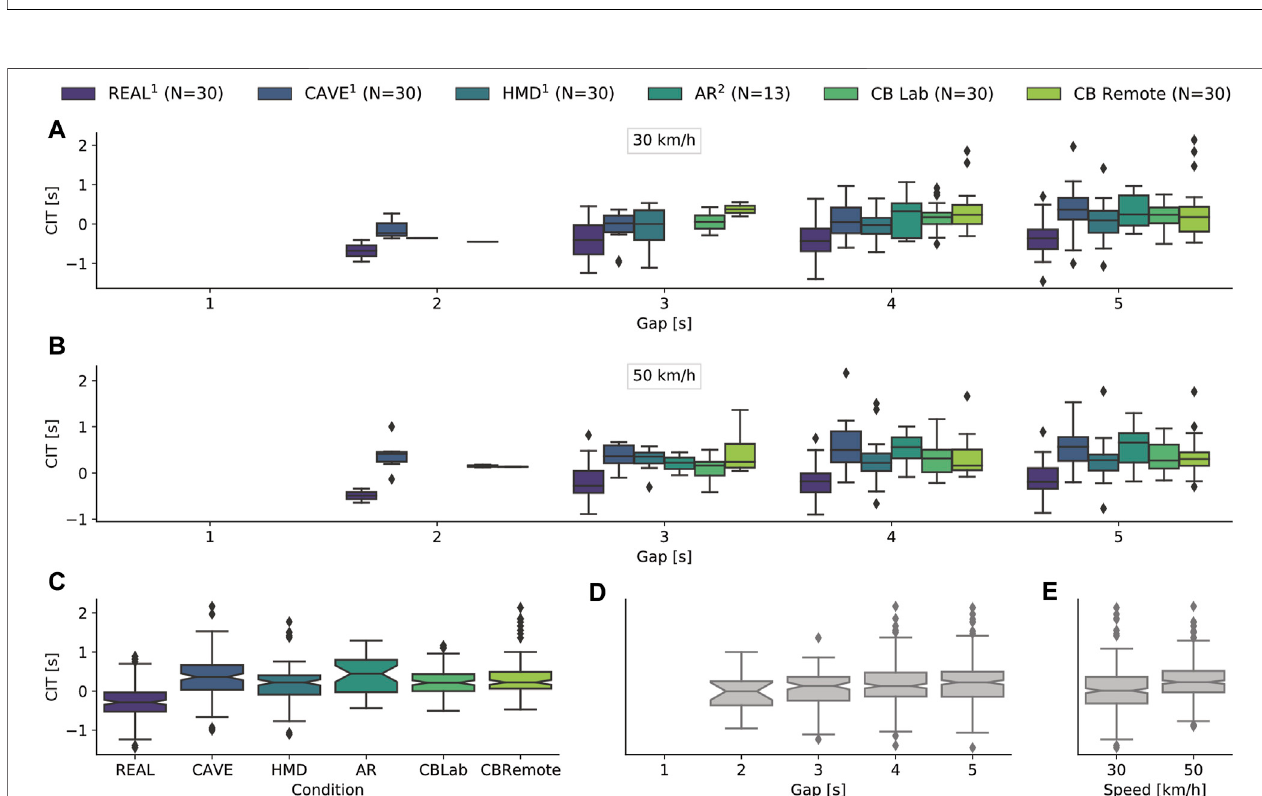
FIGURE 7 | Descriptive data of crossing initiation times (CIT). (A) and (B) show CITs as a combination of vehicle gap and test environment, subdivided for both levels of speed. The bottom three plots each represent a single independent variable. The CIT is shown as a function of (C) the experimental environment, (D) the gap sizes and (E) the speed levels. The experimental data in REAL, CAVE and HMD were collected in Schneider et al. (2021). The experimental data in AR were collected in Maruhn et al. (2020).